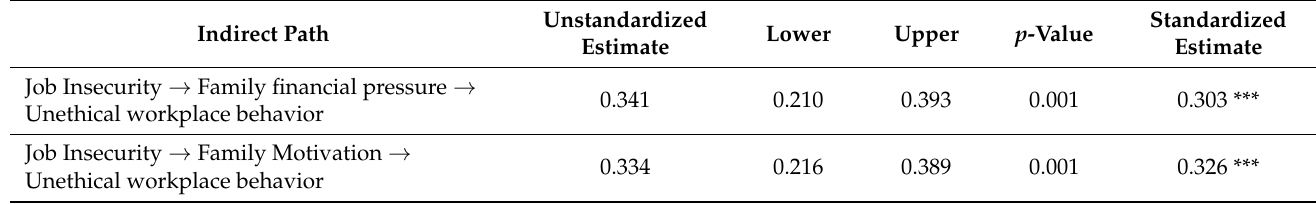
Table 4. Calculating mediation effects from Amos